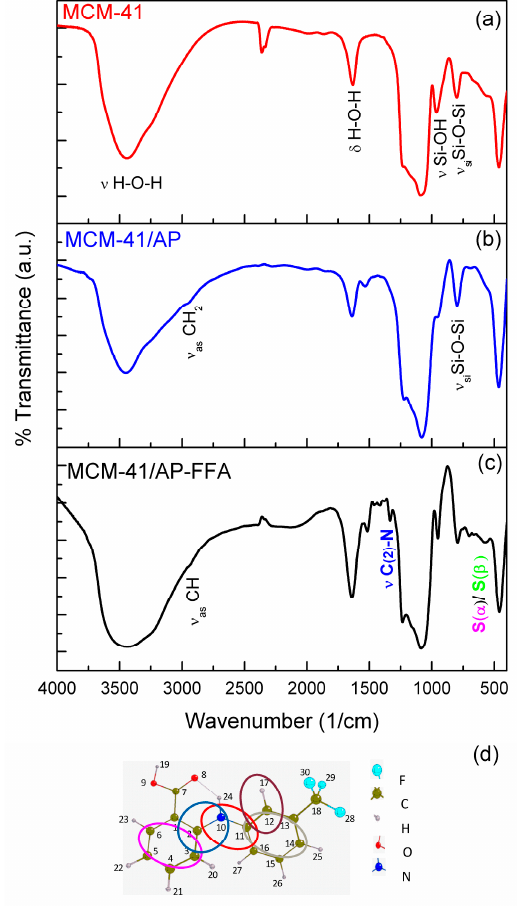
Figure 4. Fourier transform infrared spectroscopy (FTIR) survey spectra of ( a ) MCM-41, ( b ) MCM-41/AP, ( c ) MCM-41/AP-FFA, and ( d ) Molecular structure of FFA.